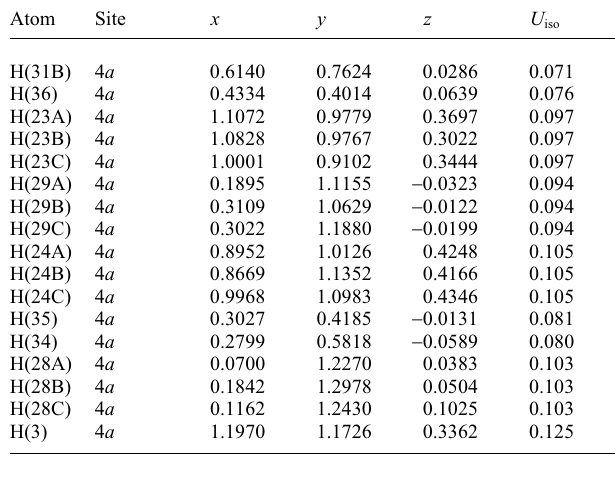
Table 3. Atomic coordinates and displacement parameters (in Å 2 )